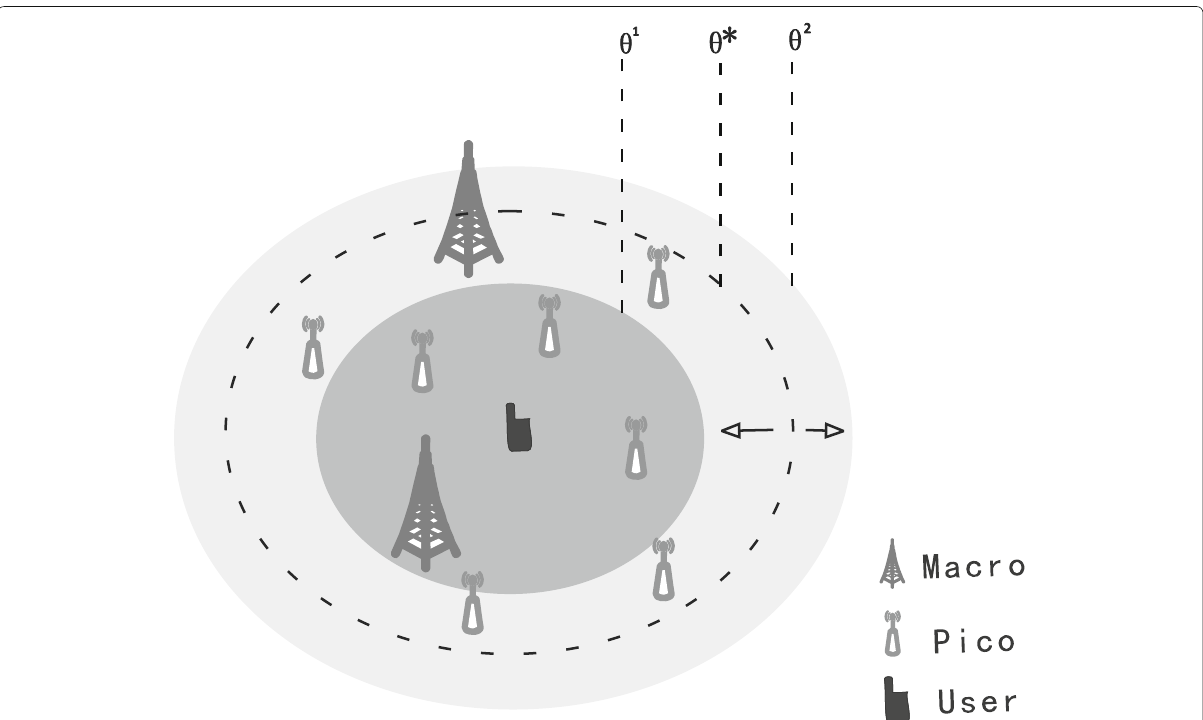
Fig. 3 The typical user is served by macro and pico BSs, where the dashed circle denotes the normalized RSS threshold θ ∗ , while θ 1 and θ 2 denote the macro-tier and pico-tier RRS thresholds,